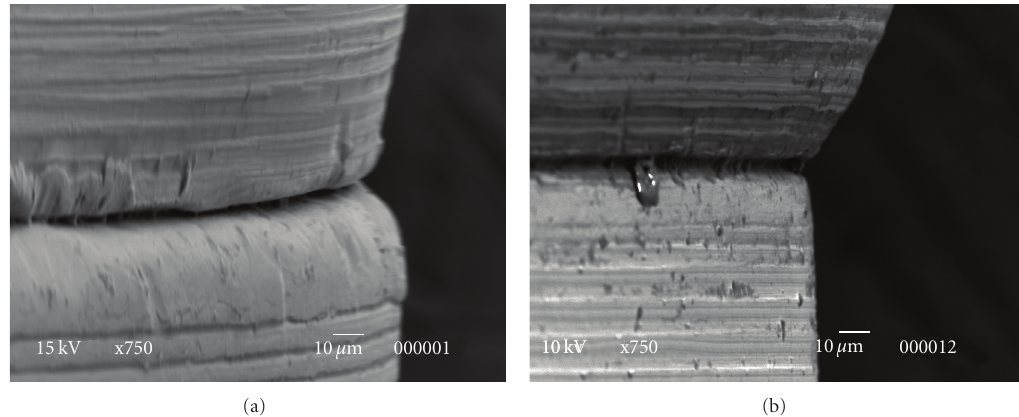
Figure 4: SEM Pictures of the marginal fit of interface implant-abutment of a representative specimen of SIN (a) and 3i (b) after the sealing capability